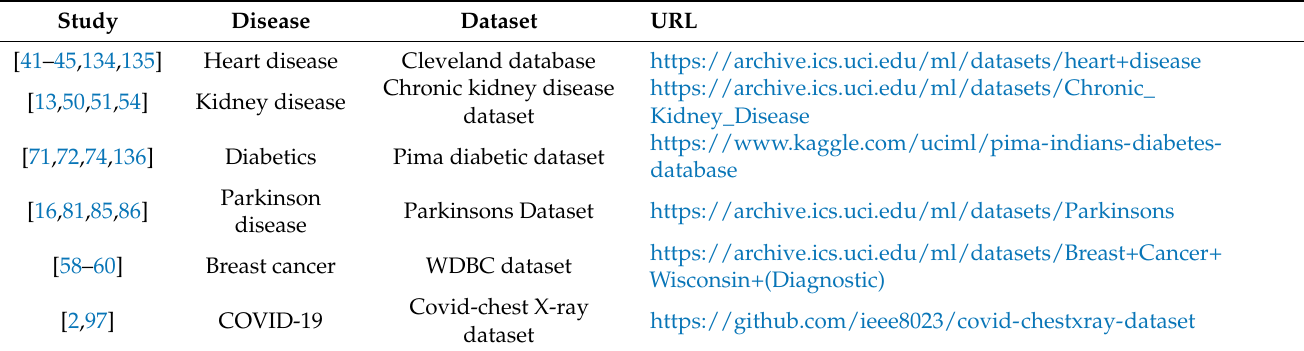
Table 11. Most widely used disease diagnosis dataset URL along with the referenced literature (accessed on 16 December